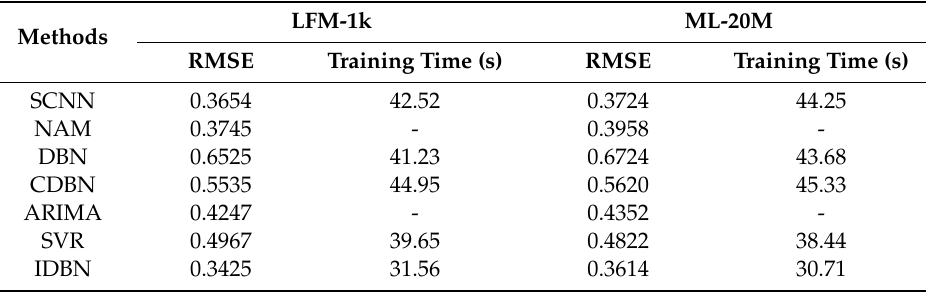
Table 2. Comparison results of popularity prediction based on time